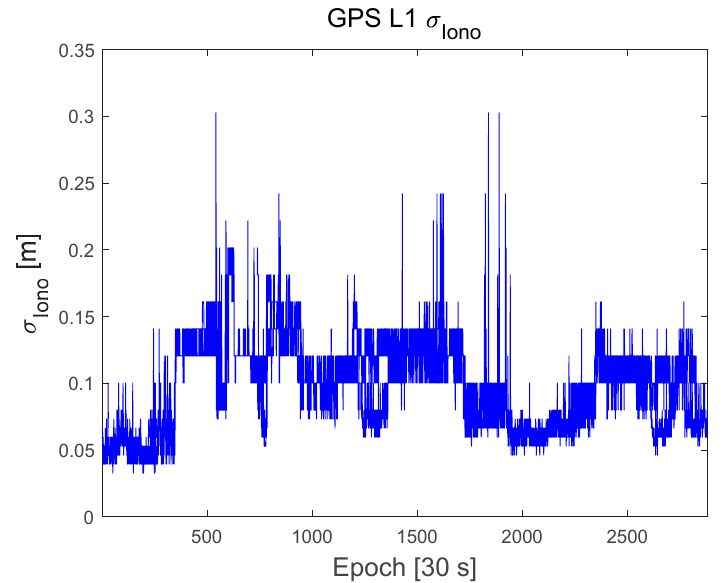
Figure 4. Time series of the Ionospheric correction quality, σ iono , in meters.